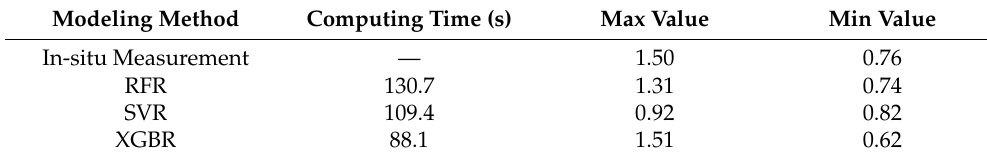
Table 4. Statistical information of the UAV-borne image inversion based on the different models.